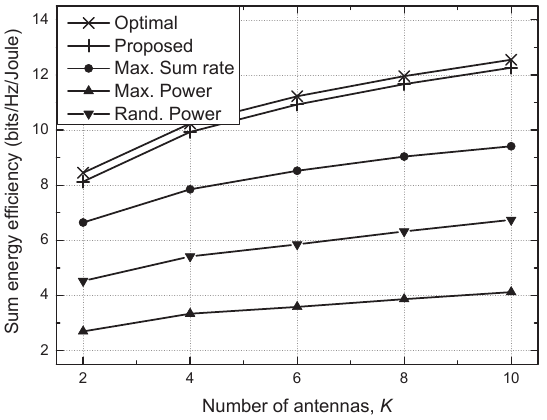
Figure 5. Sum energy efficiency vs. the number of antennas ( K